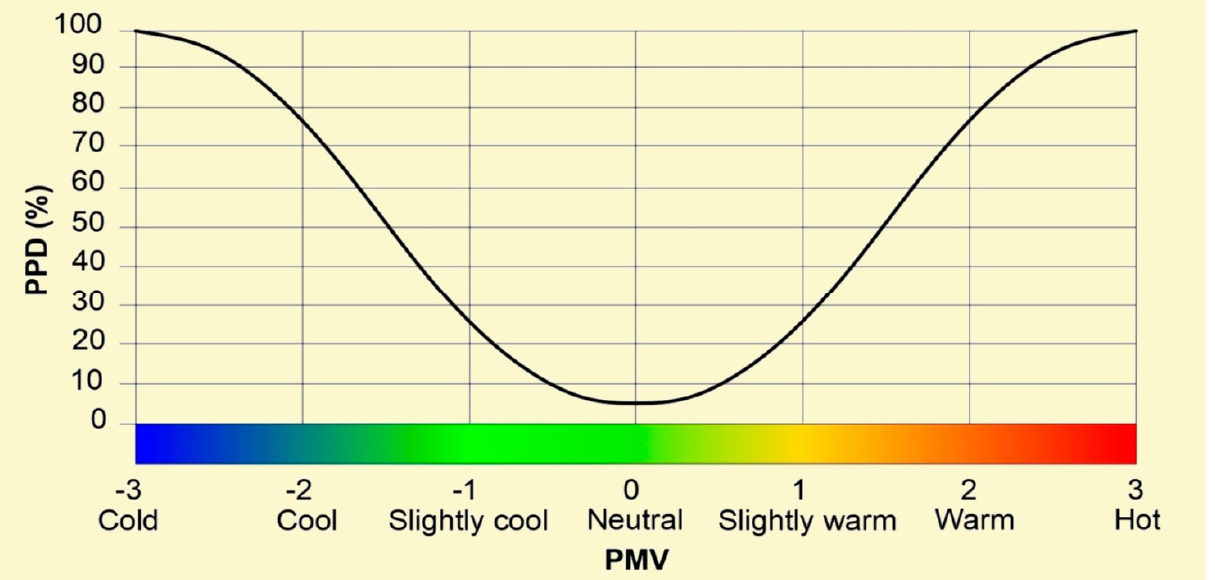
Figure A2. Symbol legend for the Comfort Map References 1.